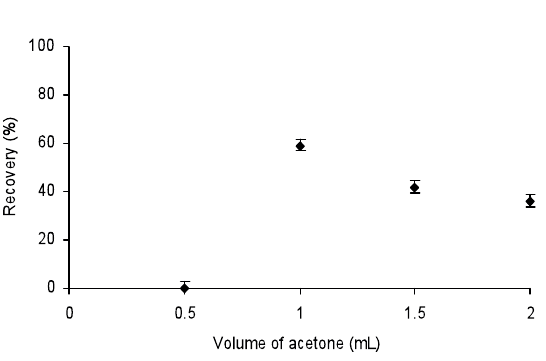
Figure 6. Effect of solution pH on extraction recovery (analyte concentration 1 mg L -1 , volume of disperser solvent and extraction solvent were 1 mL and 15 µL, respectively, n = 3).